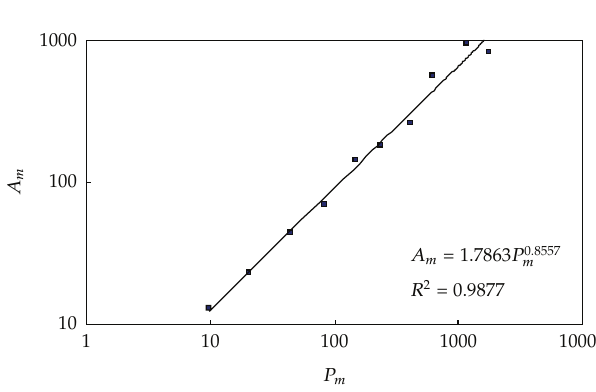
Figure 6: The allometric scaling relation between the average built-up area and urban population of China’s hierarchy of cities (cid:3) 2005 (cid:4)